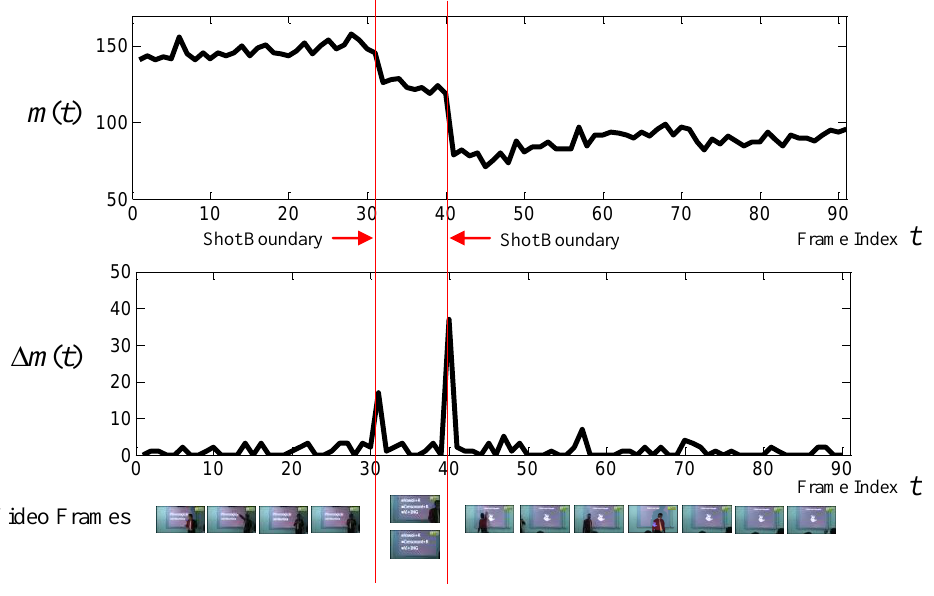
Figure 3. Example of the proposed shot boundary